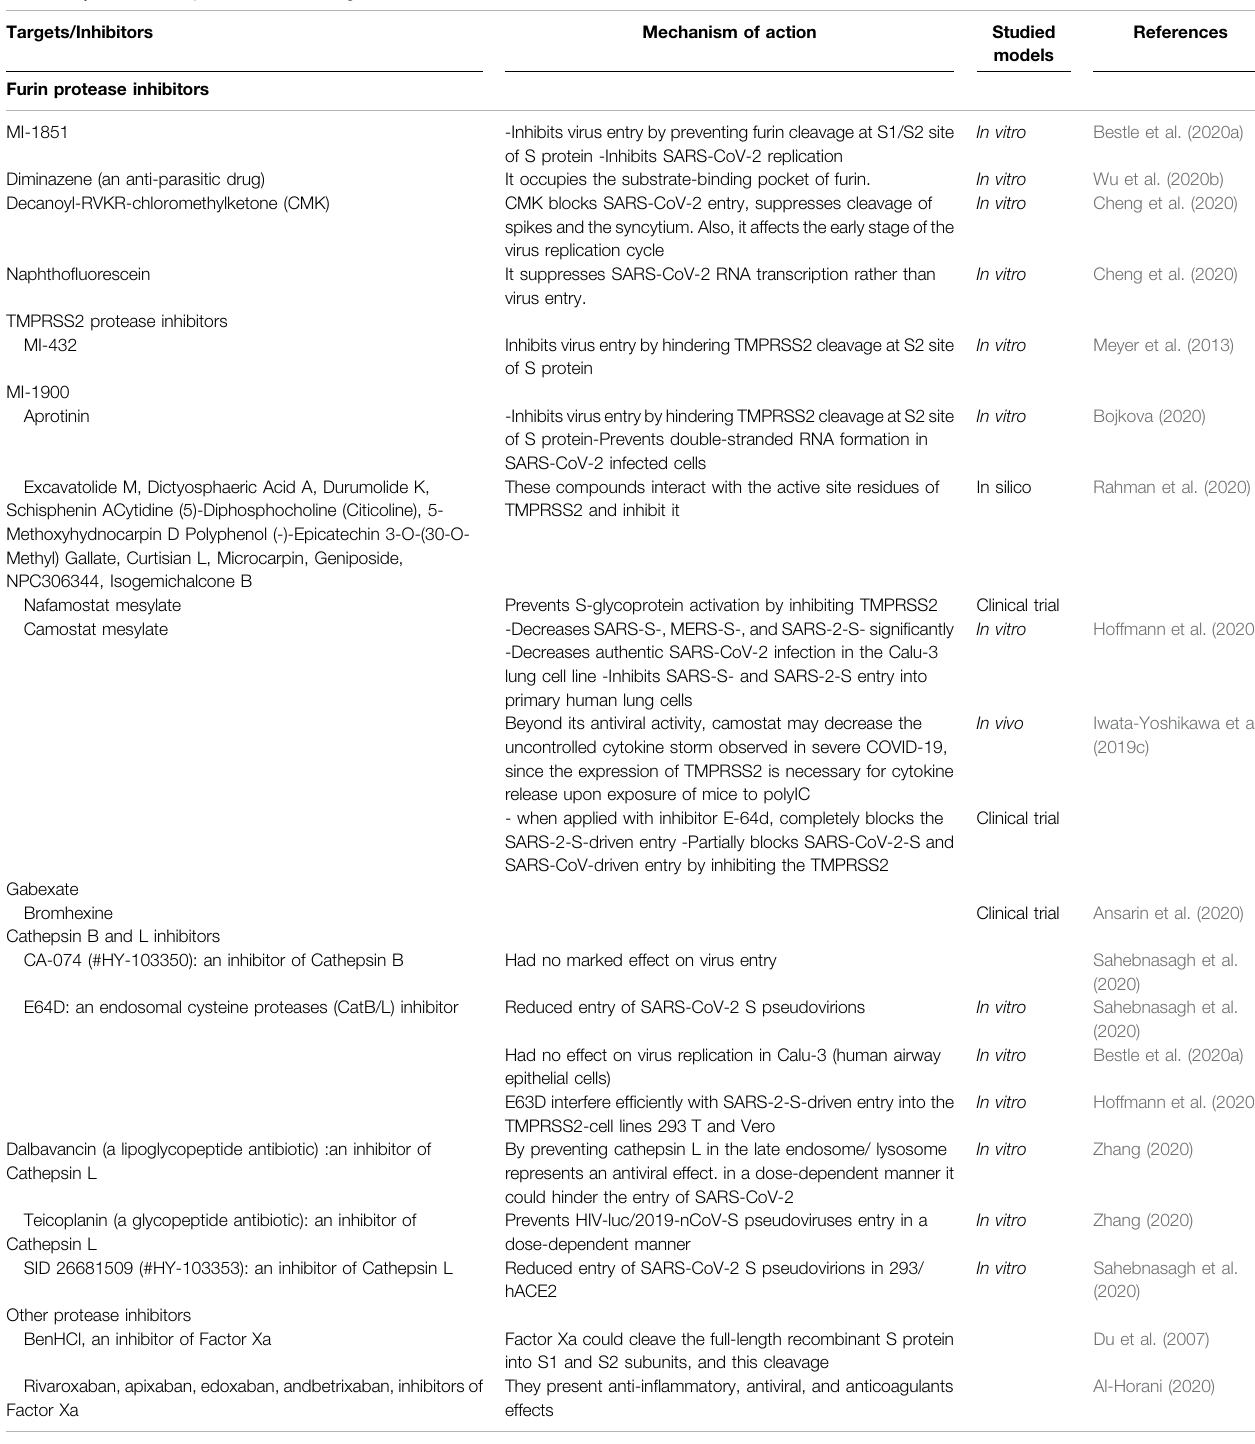
TABLE 1 | A list of host protease inhibitors against